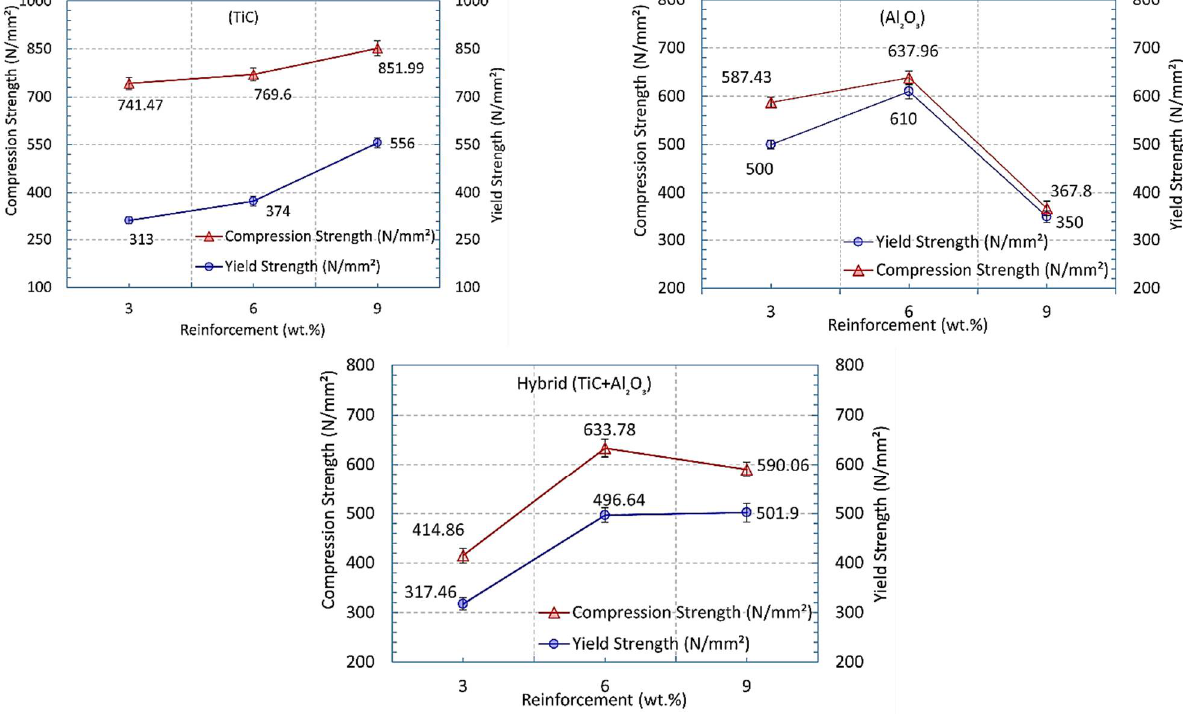
Figure 9. Effect of nanosized TiC and Al 2 O 3 contents on the mechanical properties of the Cu-based composites prepared by spark plasma sintering.